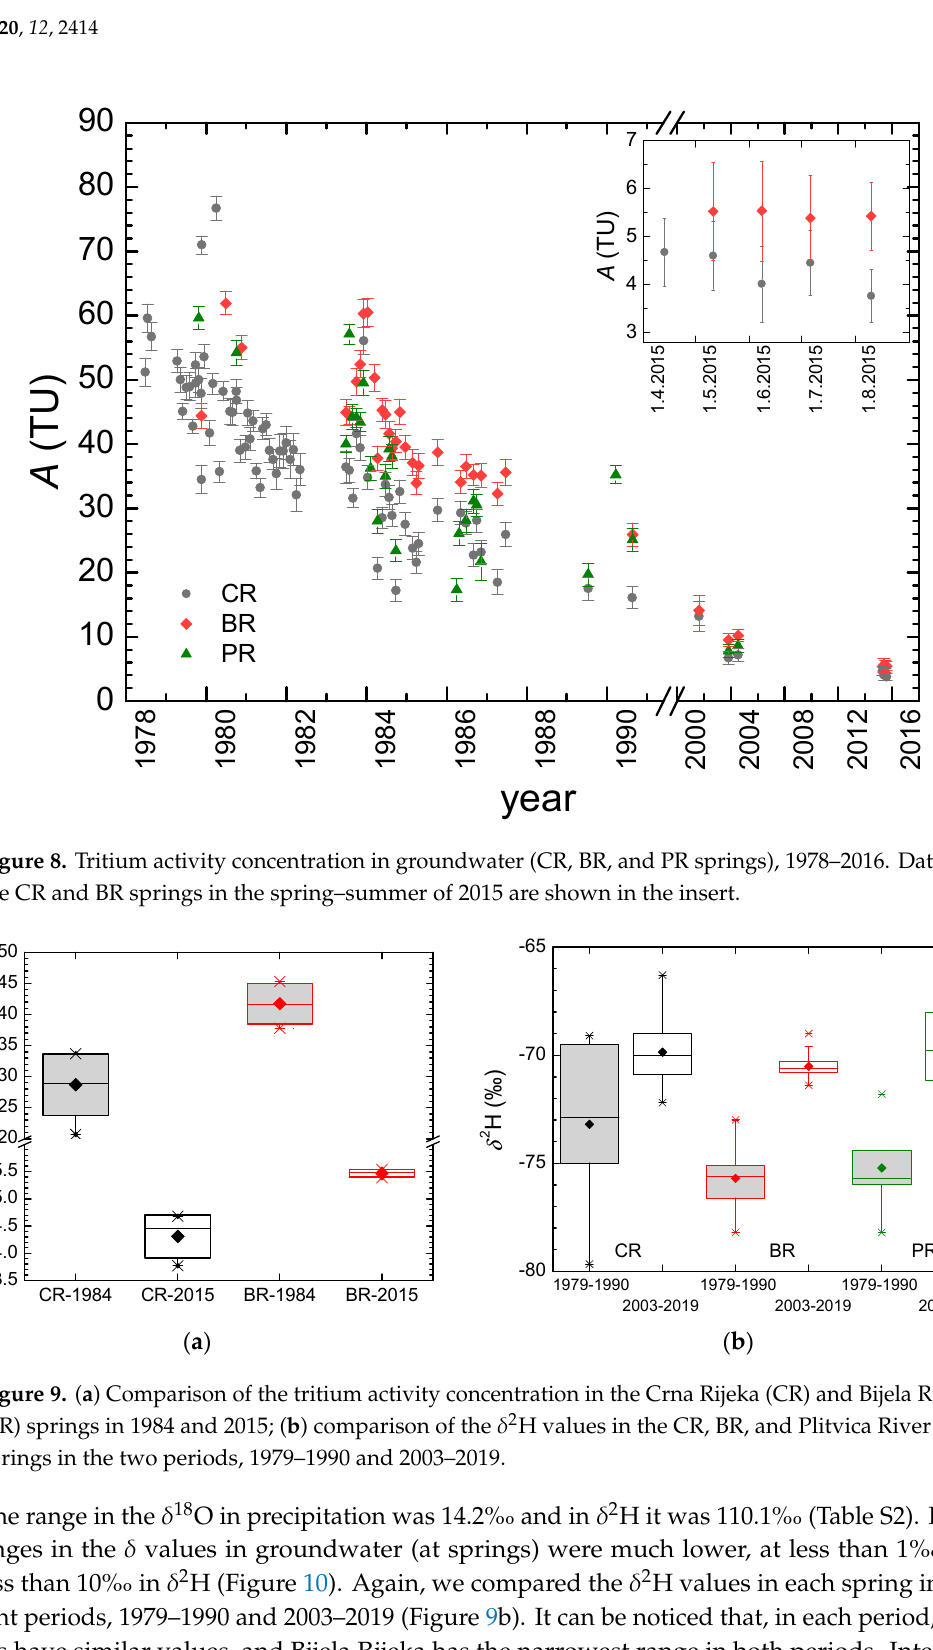
month Figure 7. Deuterium-excess values in the precipitation at Plitvice Lakes, 2003–2006 monthly data, and mean monthly values. 3.3. Groundwater